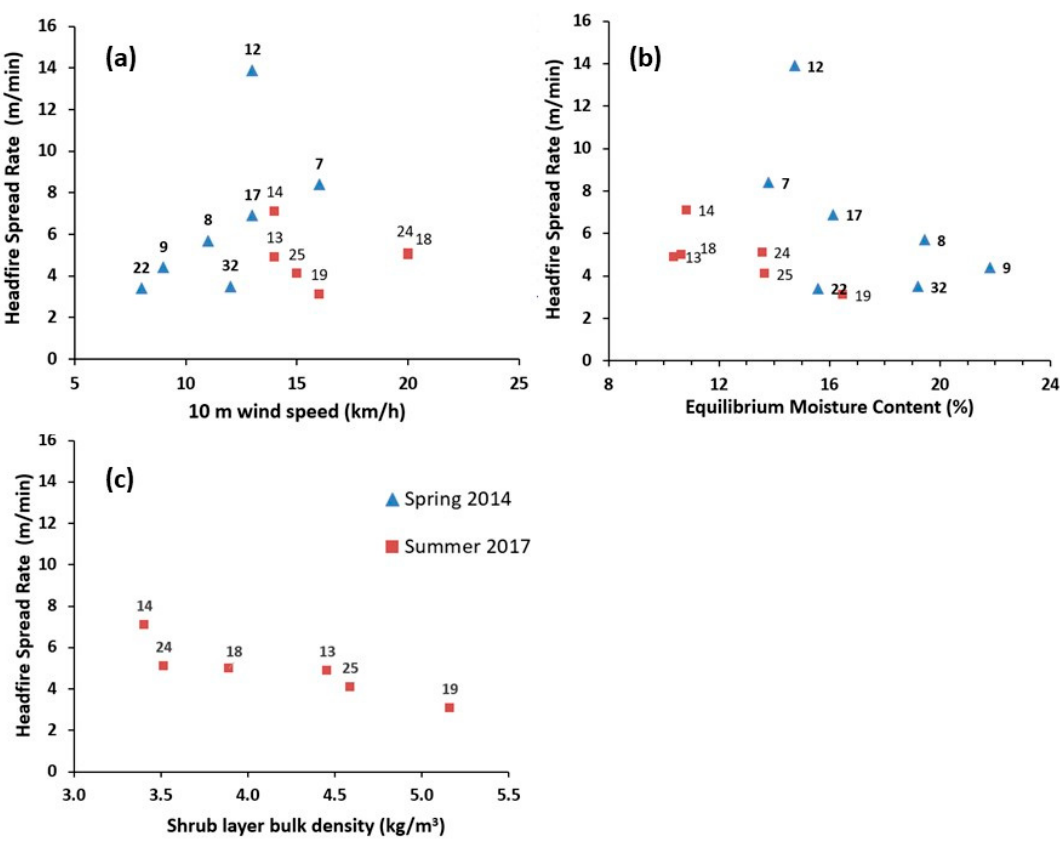
Figure 6. Observed spread rates compared with recognized factors previous studies have identified as influencing fire behaviour. ( a ) 10 m open wind speed (km / h), ( b ) dead fine fuel moisture content in elevated fuels (%) and ( c ) shrub layer bulk density (kg / m 3 ).